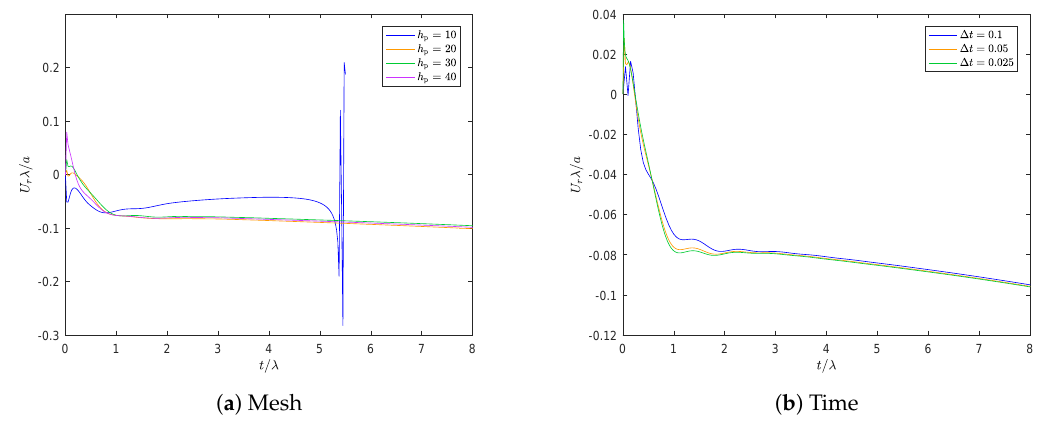
Figure 3. Migration velocity of a particle placed at a distance 3 a from the inner cylinder of a Couette for different element sizes around the particle h p and different time step sizes ∆ t